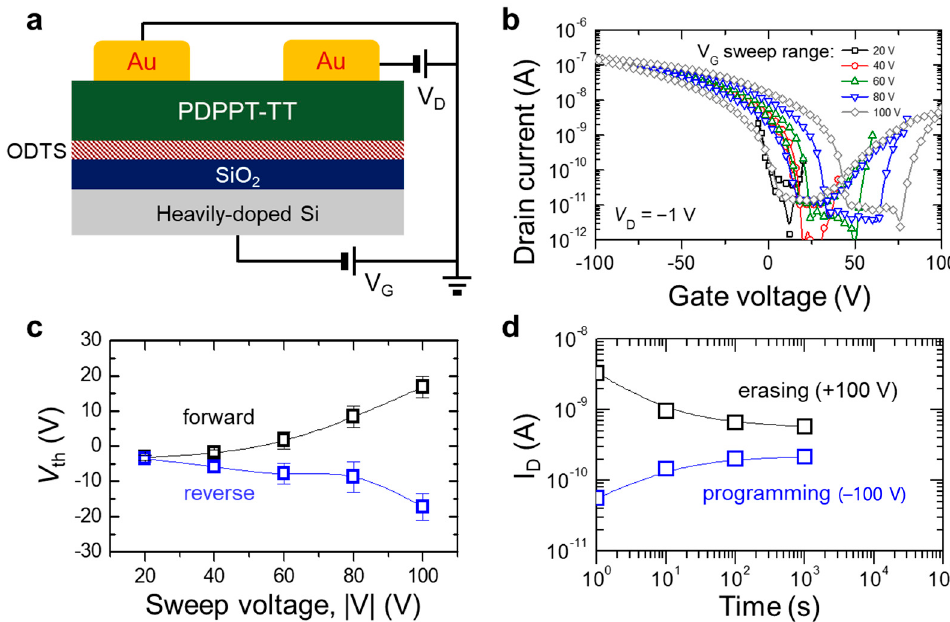
Figure 2. ( a ) Schematic of a PDPPT-TT-based transistor; ( b ) transfer characteristics of the device exhibiting ambipolar behavior; ( c ) summarized plot of the memory windows defined as the threshold voltages of forward and reverse biases; ( d ) retention time of the device with application of gate voltage of ±100 V.